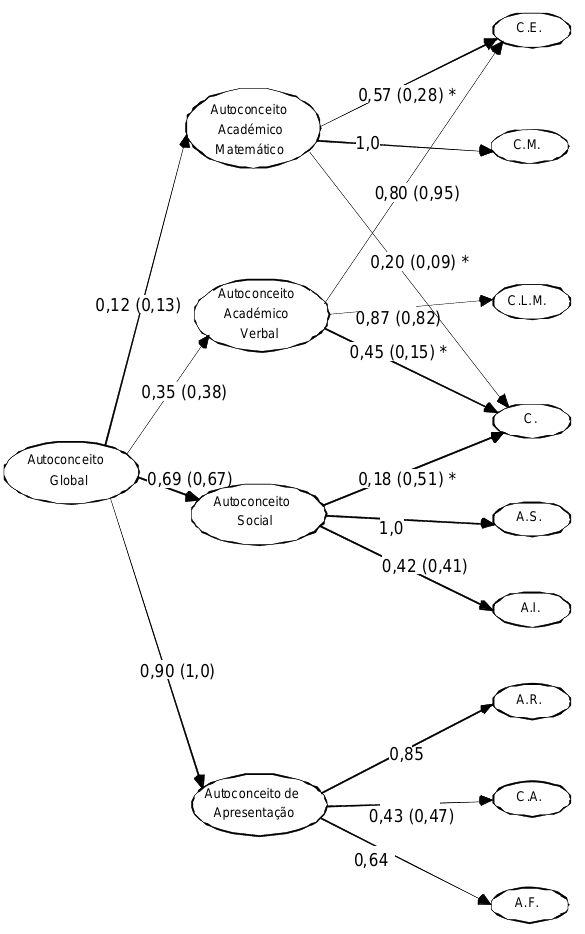
Figura 2 . Resultados em função do sucesso escolar. Nota . Alunos com sucesso (Alunos com insucesso). Quando surge apenas um valor significa que é idêntico para ambos os grupos. * p